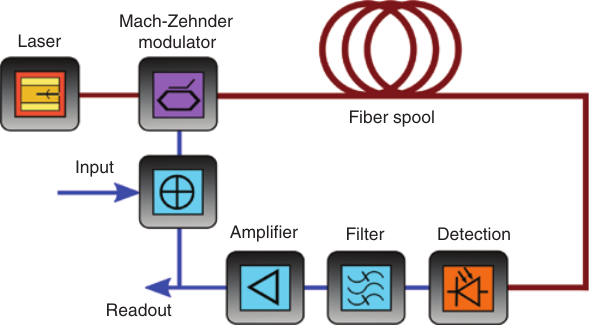
Figure 7: Scheme of the optoelectronic reservoir computer. The optical (electronic) path is depicted in red (blue) color.